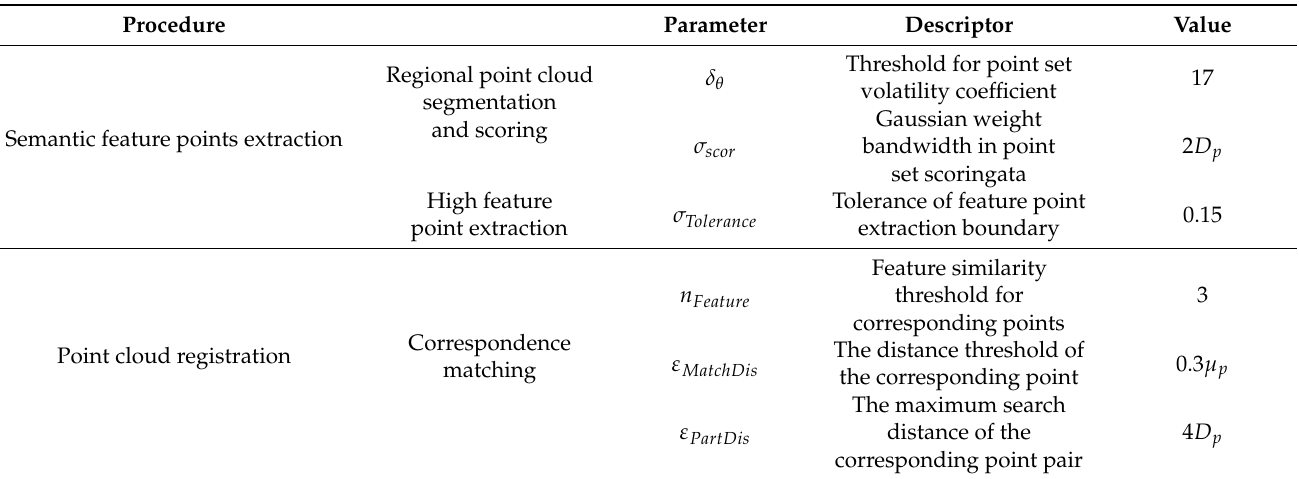
Table 1. Parameter setting for experimental